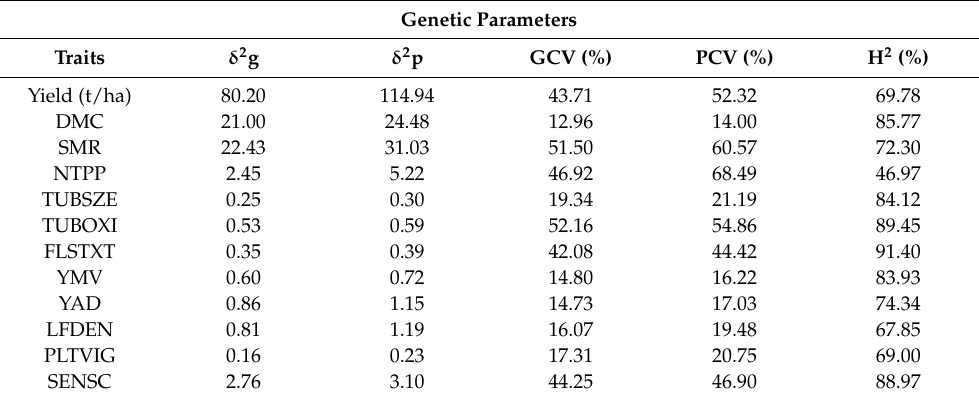
Table 5. Genetic variance, coefficient of variation, and broad-sense heritability in yam landrace accessions.